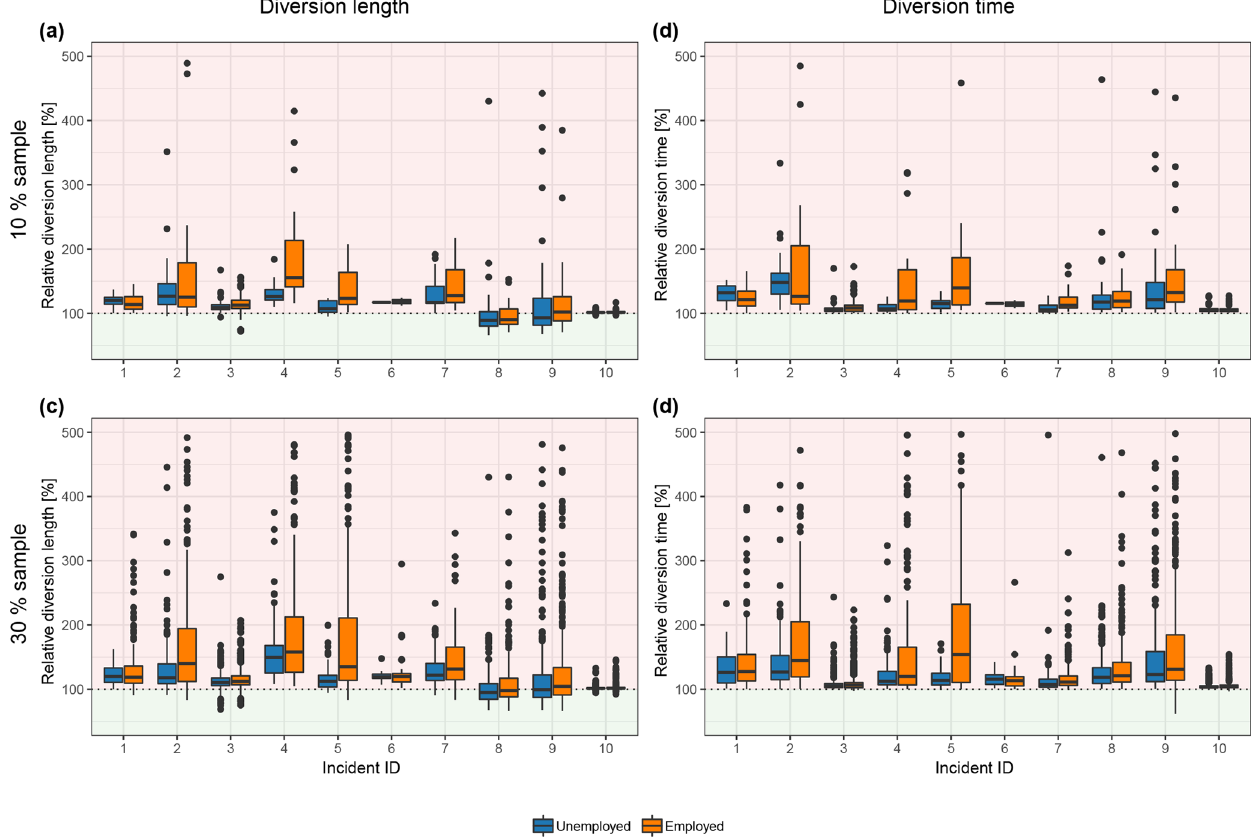
Figure 5. Relative changes of diversion length and diversion time with respect to the baseline scenario, resulting from landslide-induced network impairment. Box plots in the upper and lower rows show results for the 10% and 30% samples. Diversion costs between employed and non-employed agents are colour-coded. Note that the y axis has been limited at 500% for better readability. Occasional outliers up to 700% however do